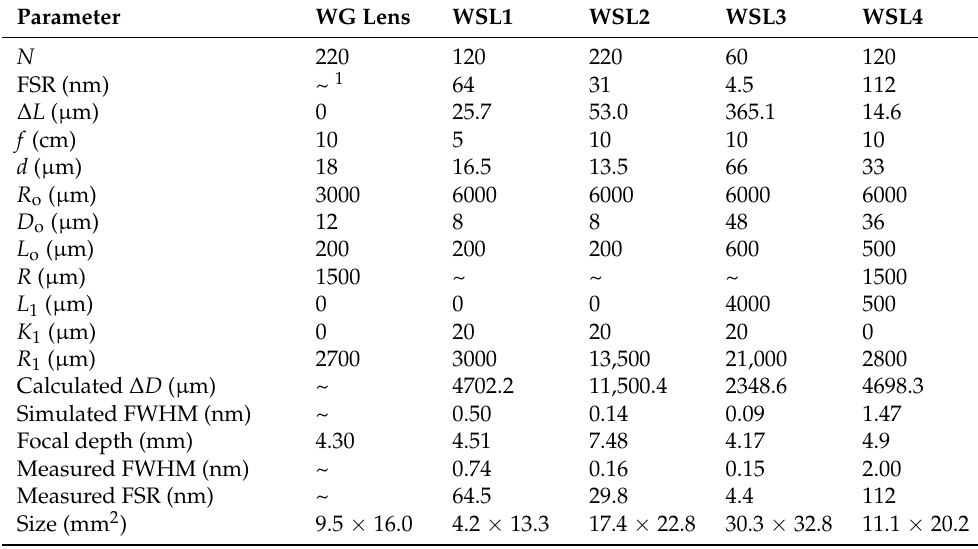
Table 1. Designed and measured parameters of waveguide lens and WSLs. Parameter